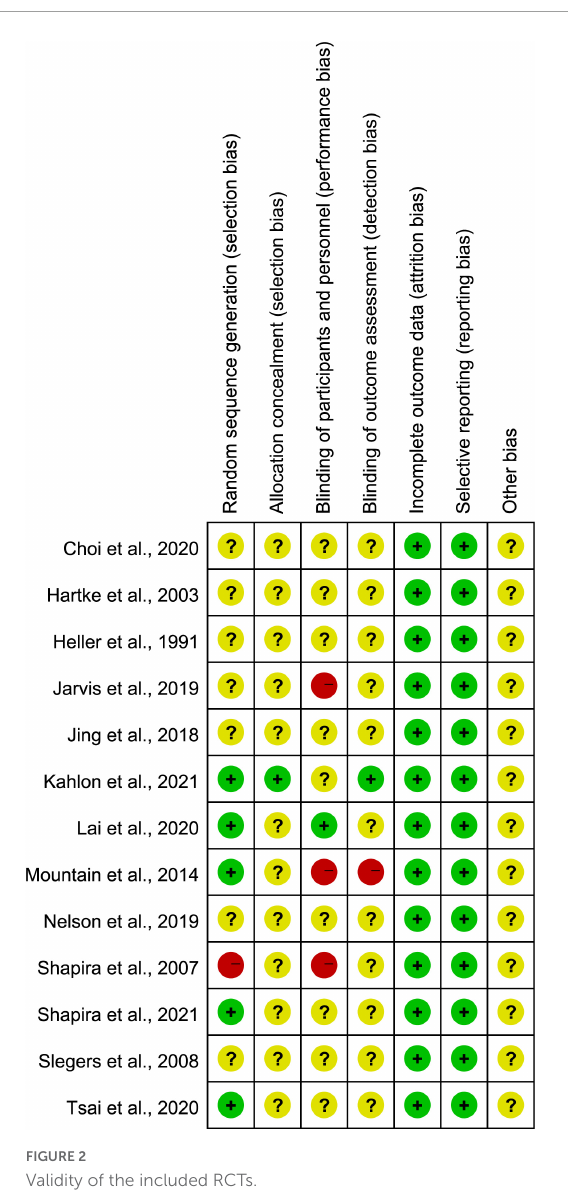
FIGURE2 Validity of the included